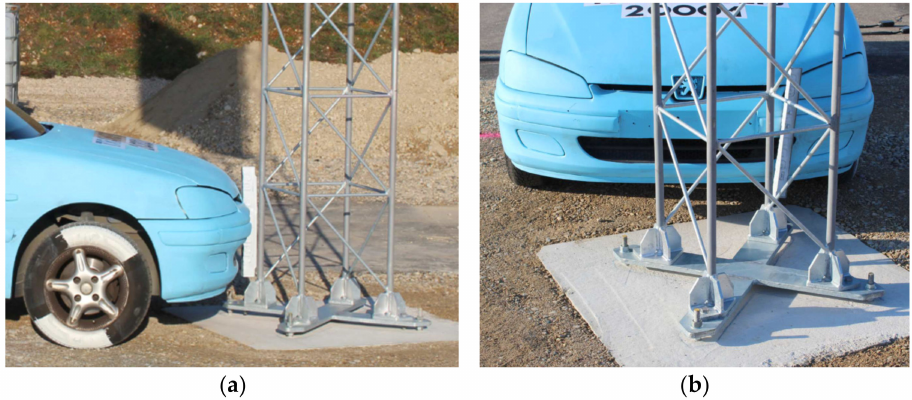
Figure 5. Mutual location of the vehicle and the mast before crash-test: ( a ) side view; ( b ) front